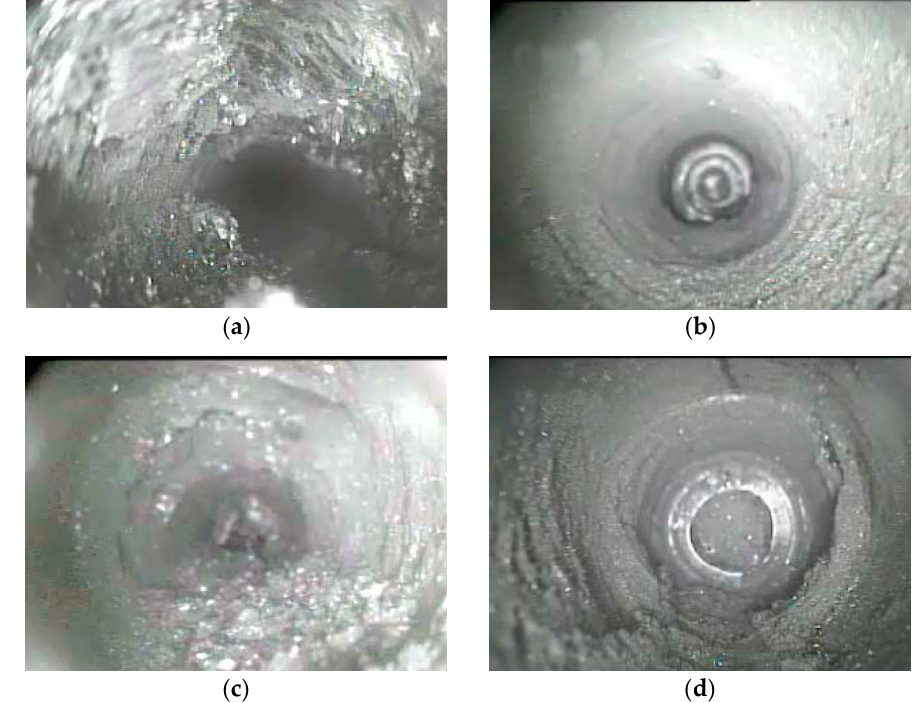
Figure 19. Borehole video results: ( a ) Depth of 3.0 m without grouting; ( b ) depth of 3.0 m with grouting; ( c ) depth of 5.0 m without grouting; and ( d ) depth of 5.0 m with grouting.